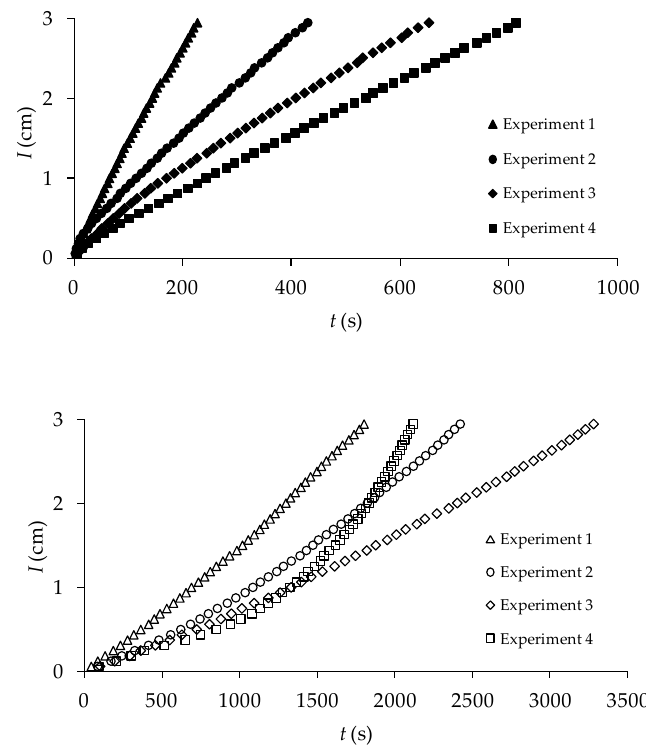
Figure 5. Dependence of cumulative infiltration on time measured at the V1 vineyard site ( upper ) and TF afforested site ( lower ).